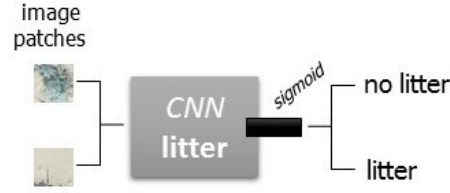
Figure 4 . General steps for the image classification of